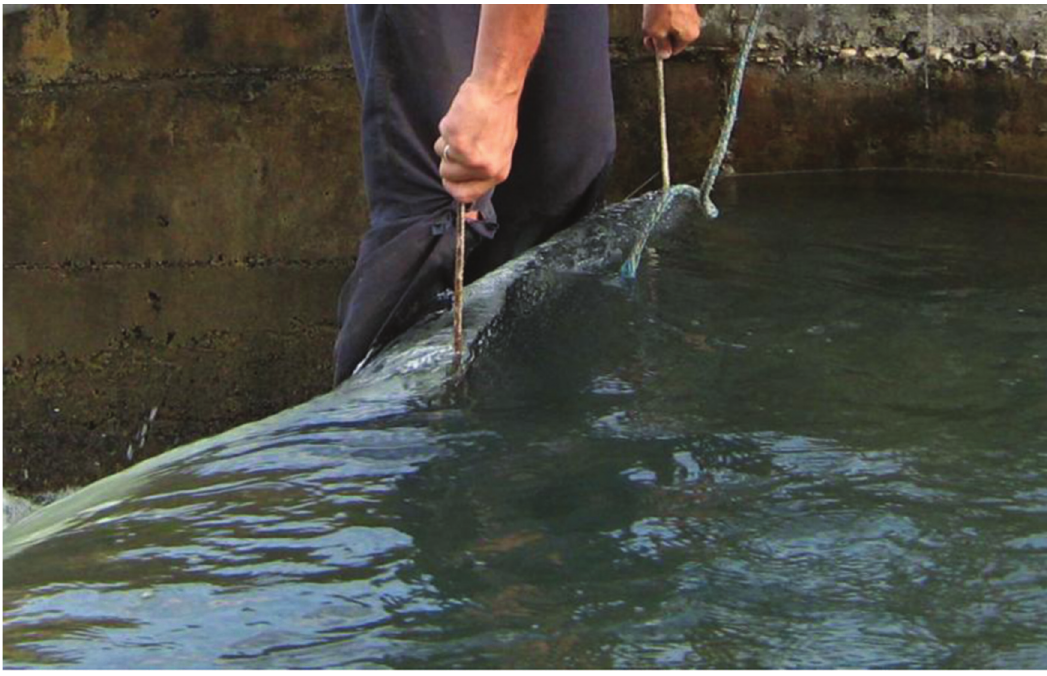
Fig. 3. Closing the pool for the emptying